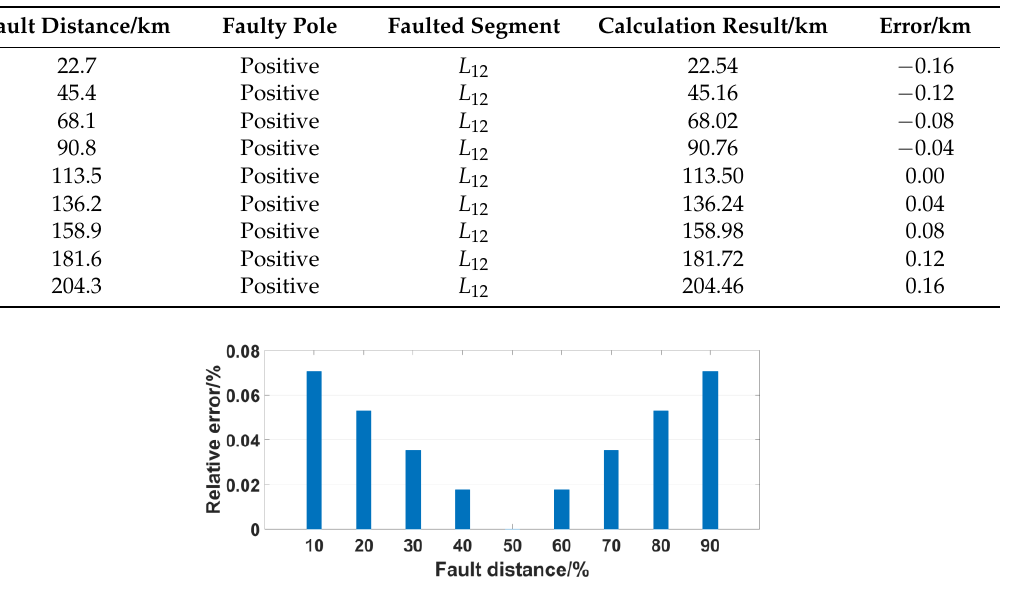
Table 7. Location results of fault with different fault distances.